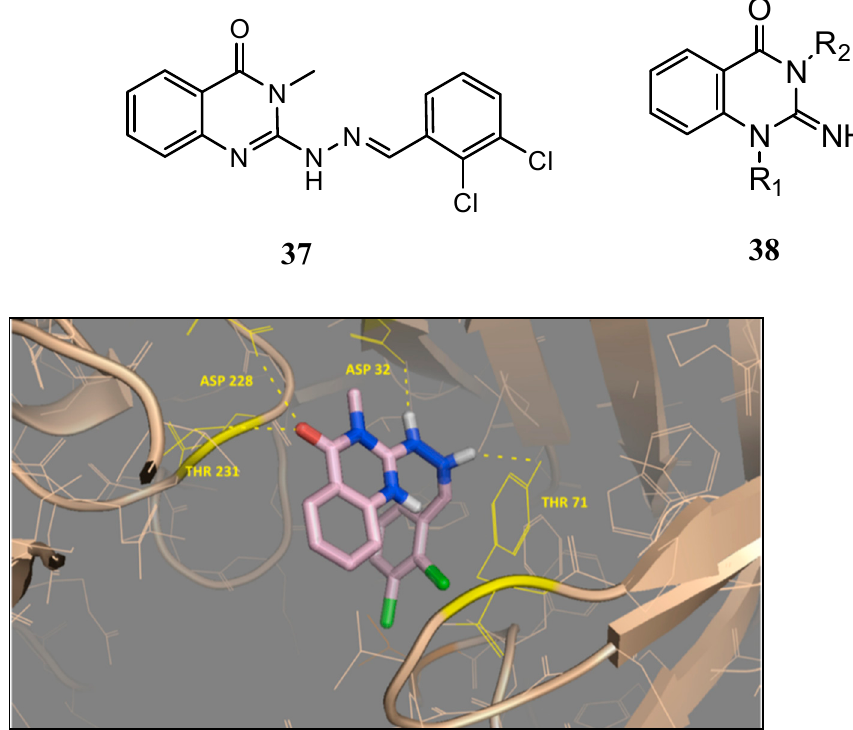
Figure 5 . Docking of the most active compound 4 h in the active site of BACE1 [34].